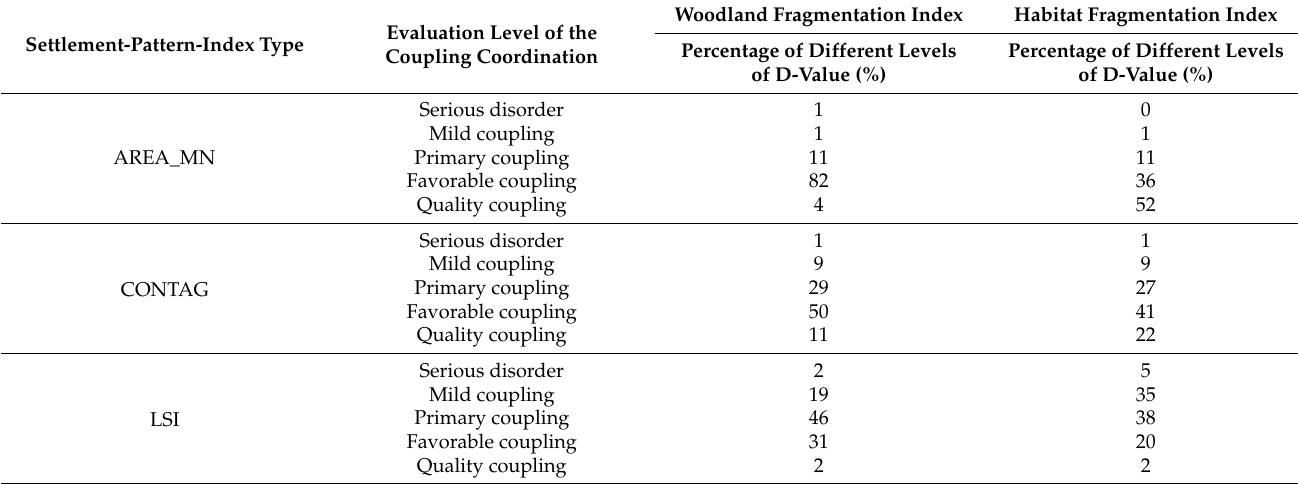
Table 6. The proportion of the number of D values of coupling coordination